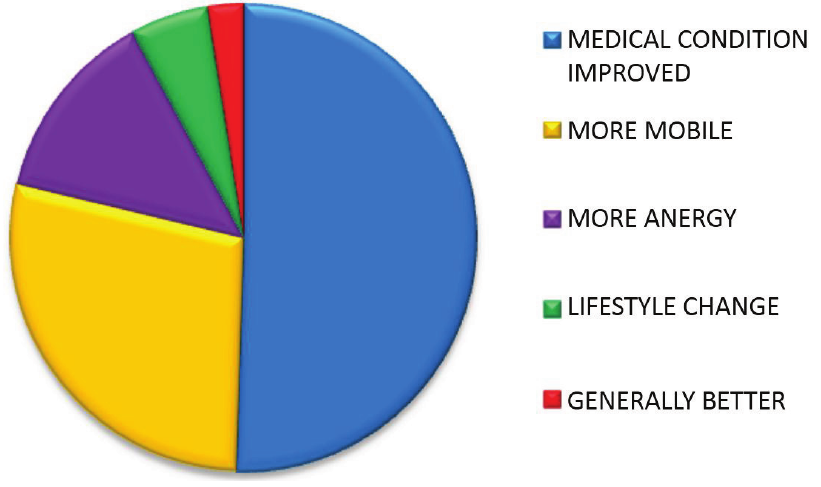
Figure 5. Proportion of reasons given by patients for feeling their health had